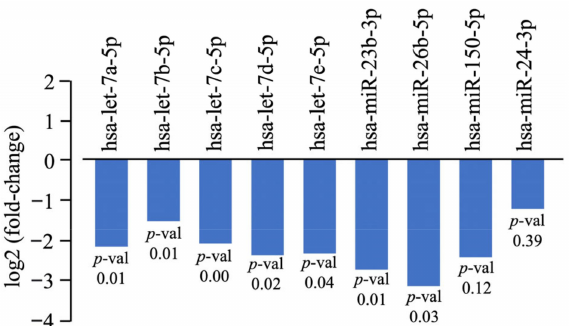
Figure 4. Selected downregulated genes among the patient group at day 7. Bar plot shows a log2 (fold change) value of downregulated genes at day 7 with p -value.